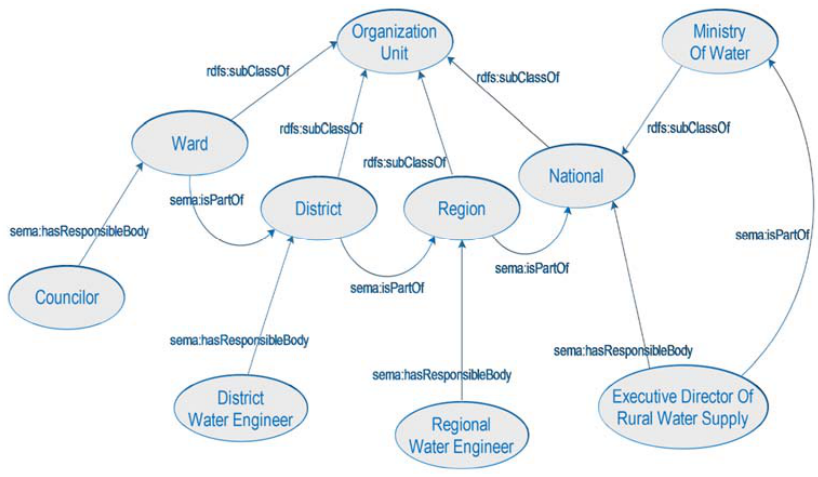
Figure 8. An example of administrative concepts for SEMA’s Water Source Reports.